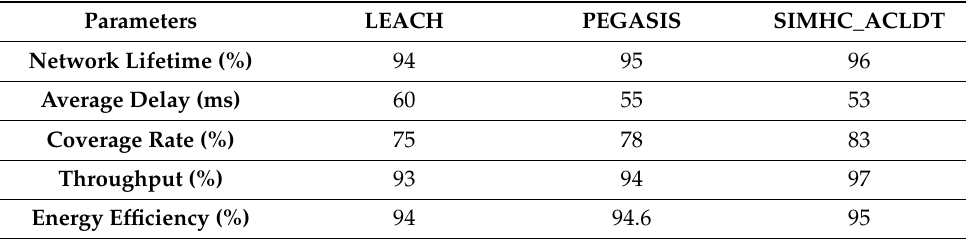
Table 2. Comparative analysis of proposed sensor system and network based on low-power commu- nication and existing